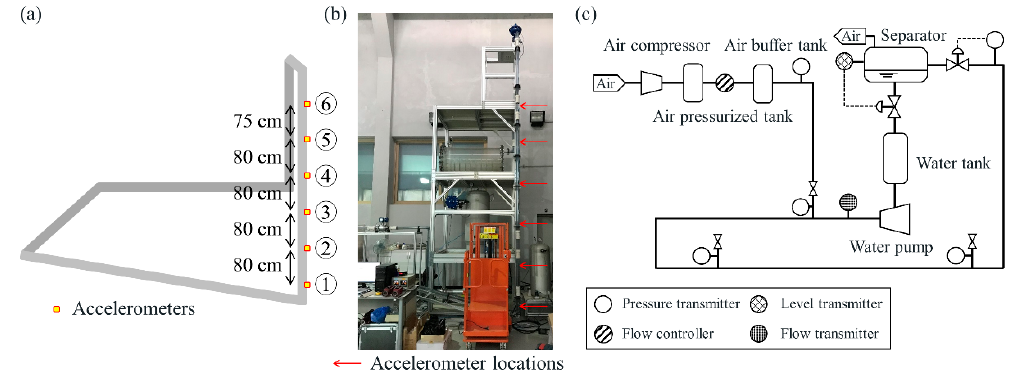
Figure 3. Experimental setup. ( a ) Location of accelerometer sensors; ( b ) photograph of the vertical riser, and ( c ) schematic diagram of the flow loop. The six sensor numbers are denoted as 1–6 in ( a ). The pipe is composed of PVC, and its inner diameter is 5.08 cm with a 5-mm thickness. The length of the inclined pipeline is 6.28 m at − 15.9° to the horizontal and the height of the vertical riser is 5.6 m.